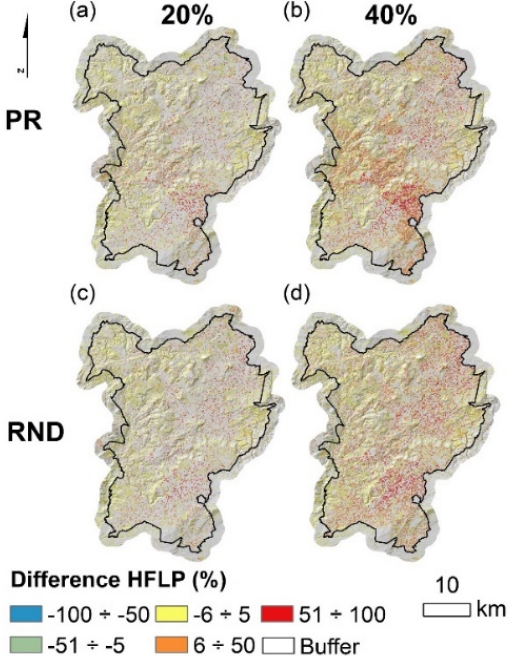
Figure 6. High flame length probability (HFLP) difference between the two spatial patterns of land abandonment scenarios tested (priority (PR; a , b ), random (RND; c , d )) and the NA conditions, considering 20 and 40% of agropastoral land abandonment.